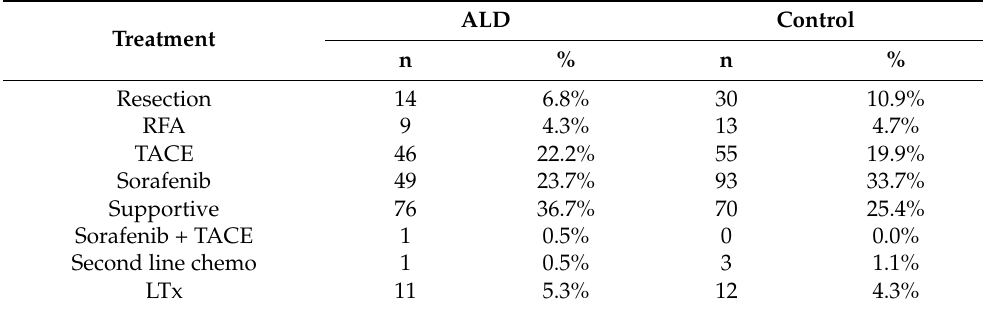
Table 3. Treatment used in the first line.